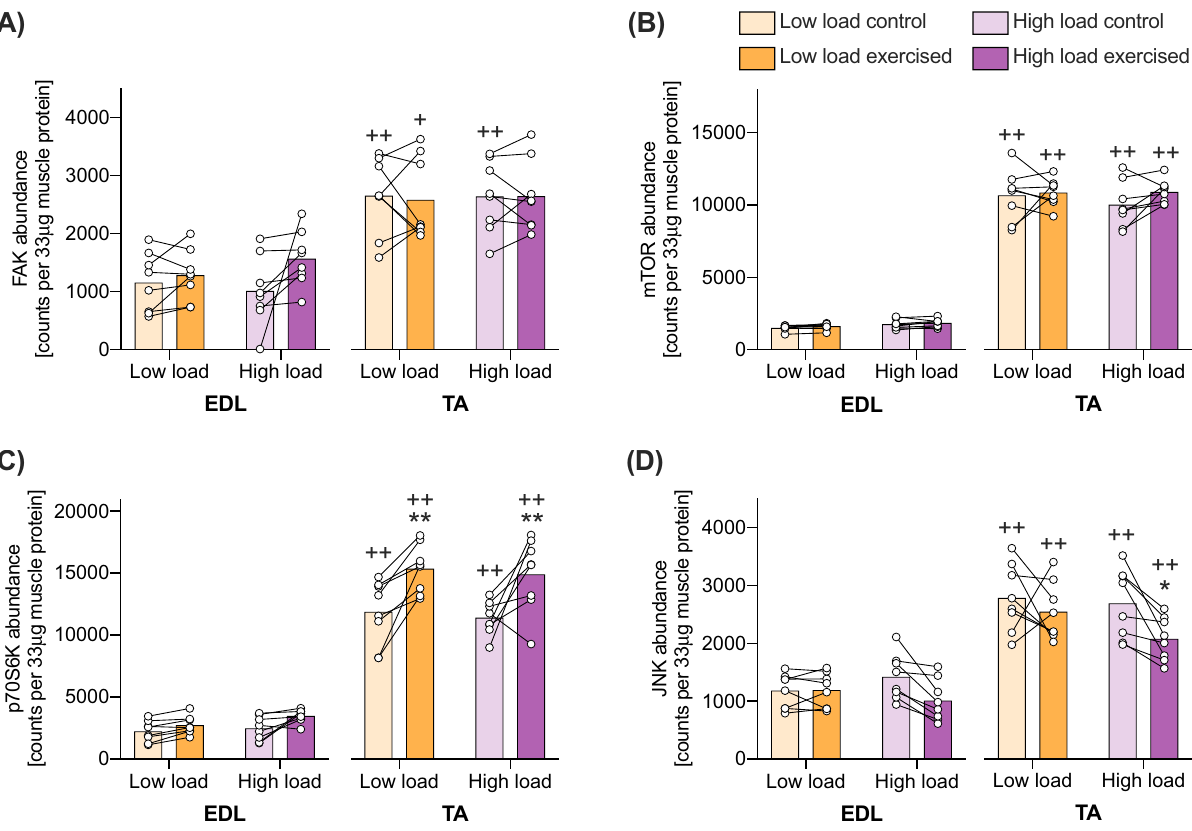
Figure 2. Kinase abundance is dependent on muscle type, and p70S6K abundance is increased by exercise in TA, while JNK abundance is decreased by exercise in a load-dependent manner in TA. Kinase abundance of FAK (A), mTOR (B), p70S6K (C), and JNK (D) as measured in 33 µg soluble protein from exercised and contralateral control TA and EDL muscles after a 28-min exercise stimulus with a high or a low load. Post-hoc significant differences denoted with *, ** p < 0.05 and 0.01 vs control leg; ++ p < 0.01 vs EDL within same exercise group. Data are presented as individual muscle values (circles), contralateral comparisons (lines) and group means (bars) (n = 8 per